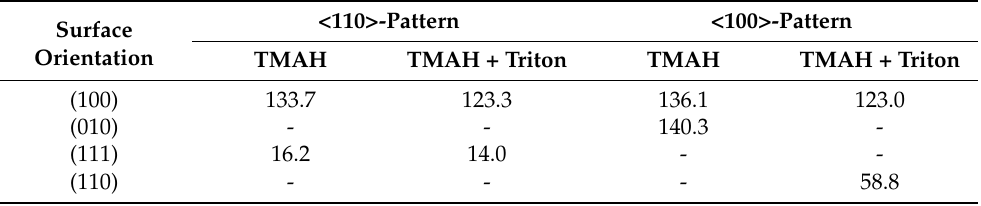
Table 1. Anisotropic etching rates of Si for various surface orientations in pure 25 wt% tetramethyl ammonium hydroxide (TMAH) with and without 0.1 vol% Triton in the patterned oxide wafers.